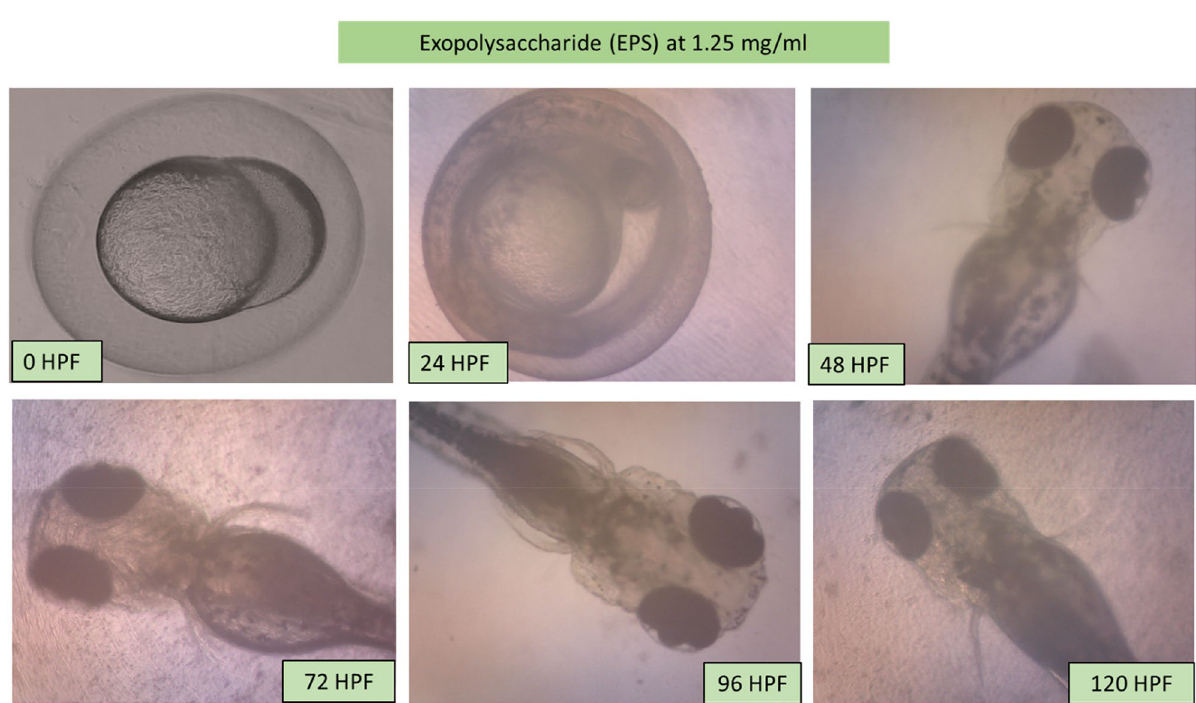
Figure 7. Illustrations of zebrafish embryo and larvae development after treated with Tiger Milk mushroom Lignosus rhinocerus strain ABI at EPS concentration of 1.25 mg/mL. Descriptions were captured using an inverted microscope at 100X (0 and 24 HPF) and 40X magnification (48–20